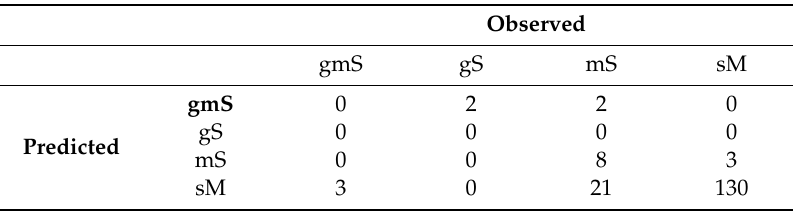
Table A7. Quantitative simplified Folk LOO CV error matrix.